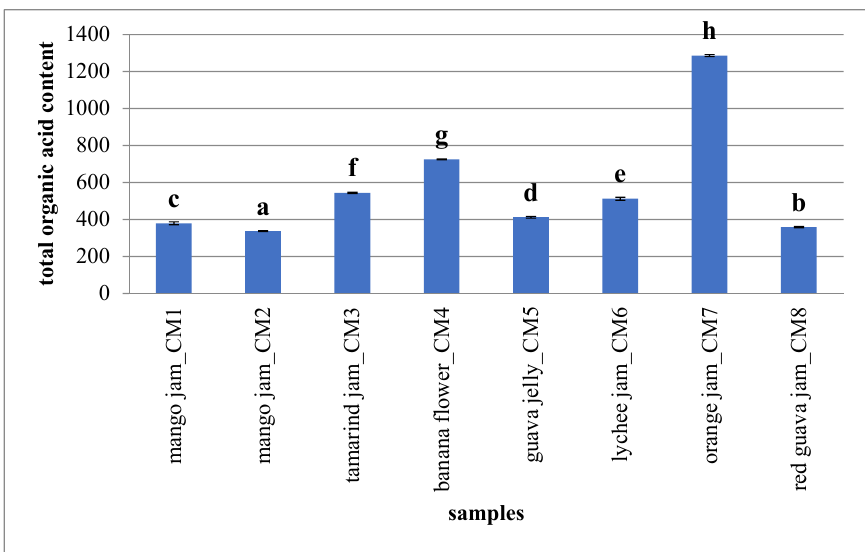
Figure 3. Total organic acid content of analysed fruit ‐ derived products. The mean value of each analysed sample is given ( N = 3). Different letters for each class indicate the significant differences at p < 0.05. Results are expressed as mg/100 g of product.